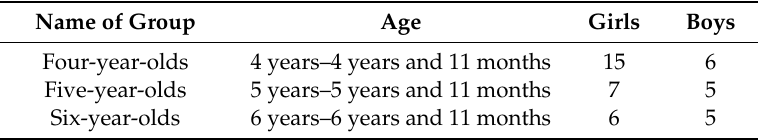
Table 1. Subjects’